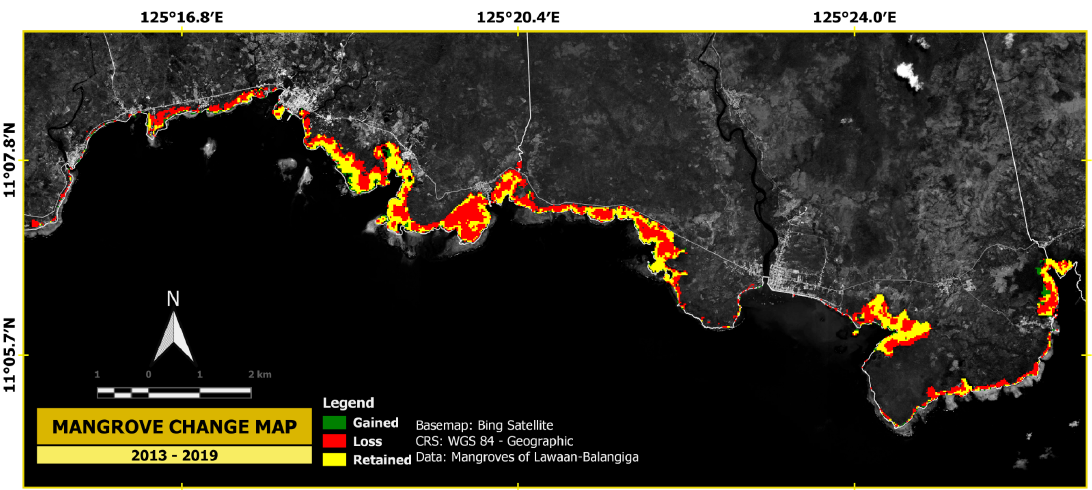
Figure 12. 2013-2019 Mangrove Area Change Map